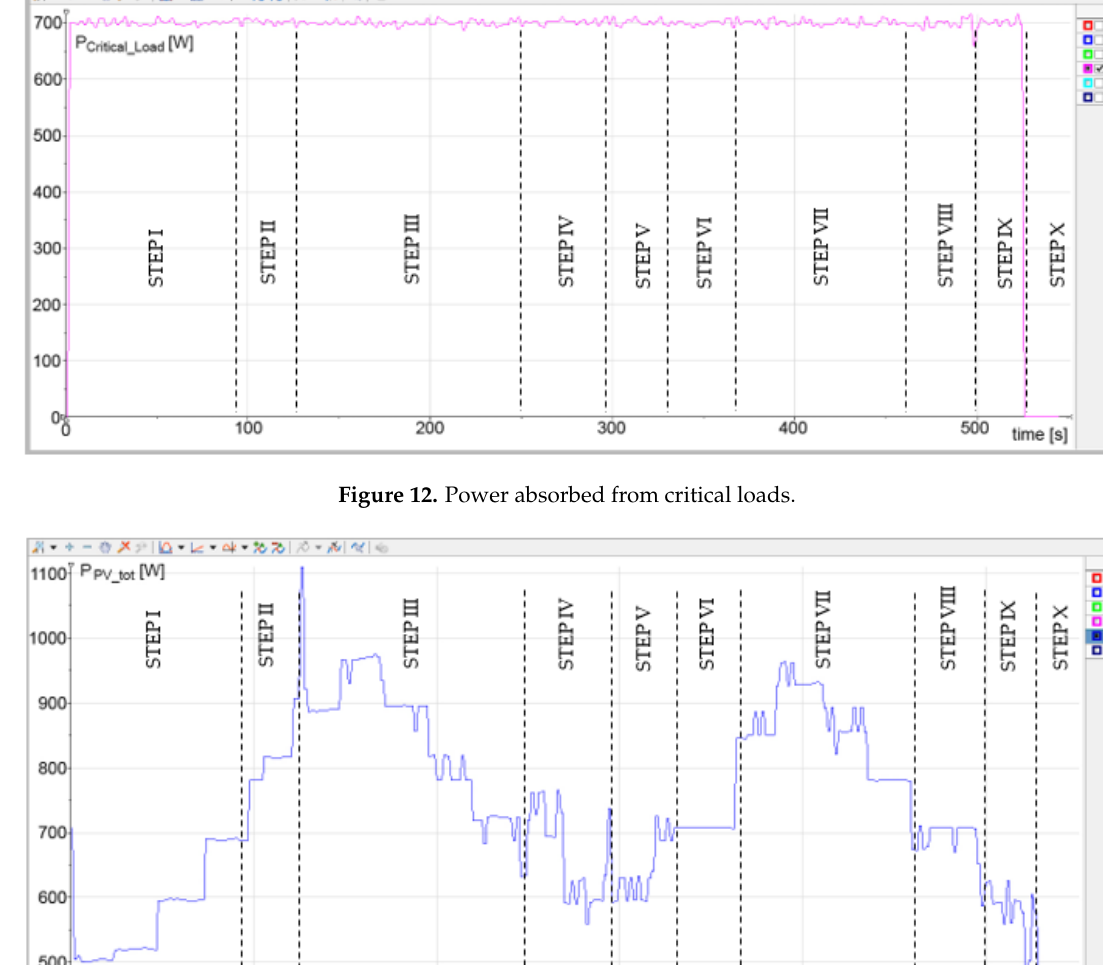
Figure 11. Power exchanged from the electrochemical energy storage system (EESS) with the SUN.